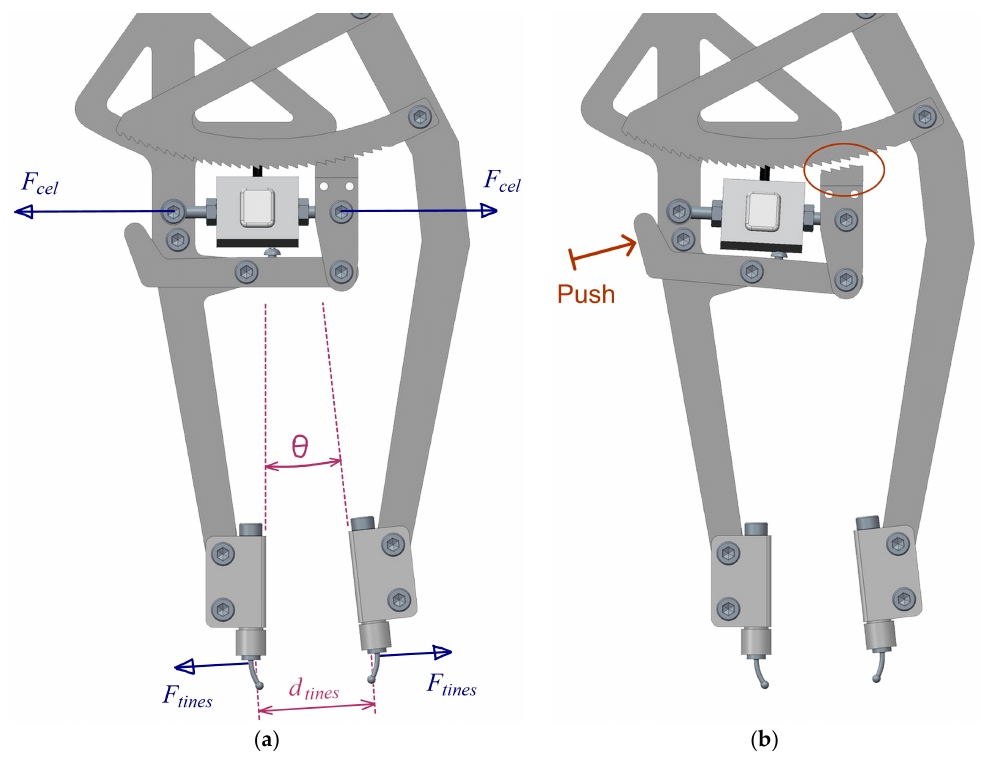
Figure 3. ( a ) Main variables involved in the measuring procedure; ( b ) Ratchet mechanism disengaged while not measuring, to separate the ends of the